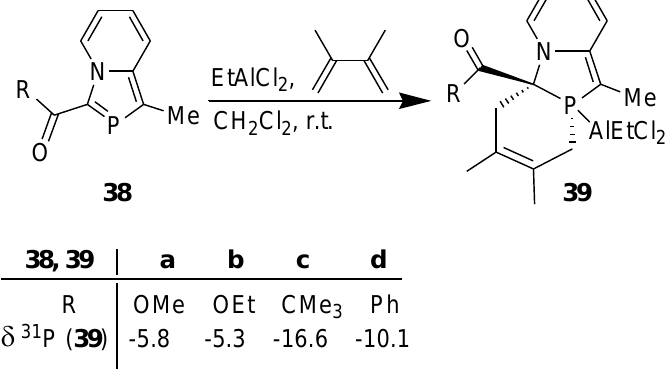
Scheme 11. DA reaction of 3-(alkoxycarbonyl/acyl)-1-methyl-2-phosphaindolizines in the presence of EtAlCl 2 .